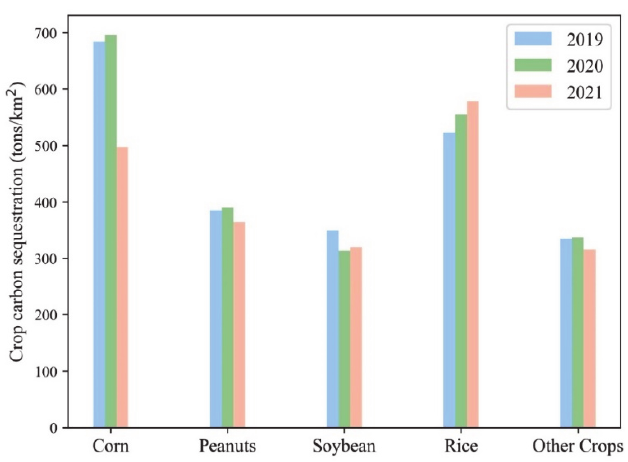
Figure 8. Estimation results of crop carbon sequestration per unit area in 2019, 2020, and